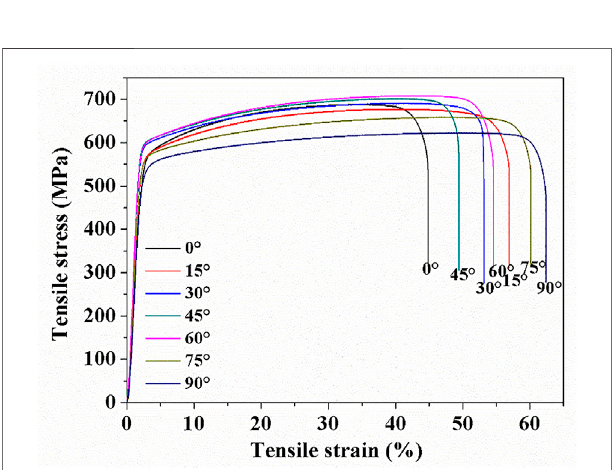
FIGURE 8 | Stress – strain curve of SLM-processed 316L SS from different angles relative to the build substrate.